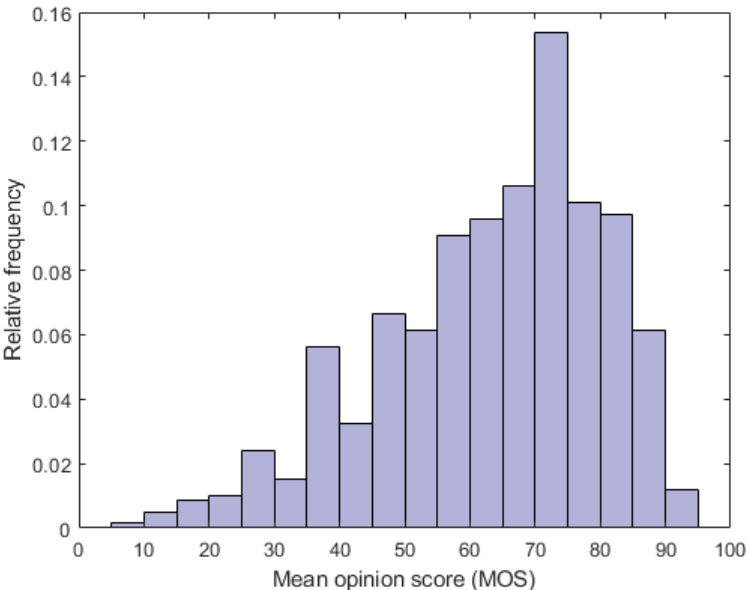
Figure 5. Empirical distribution of MOS in LIVE VQC